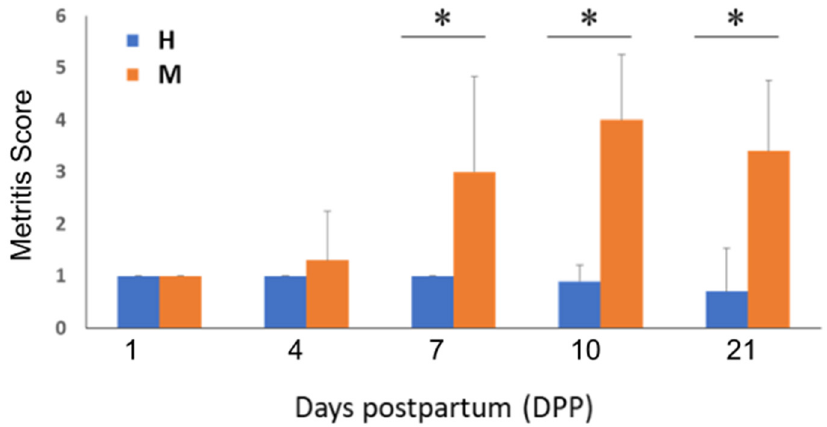
Figure 1. Comparison of endometritis score changes during the study period. Bar graph depicting averaged metritis scores for the metritis (M) and healthy (H) animal groups from 1 to 21 DPP. * Indicates statistically significant ( p < 0.01) differences between metritis and healthy animals’ endometritis scores.